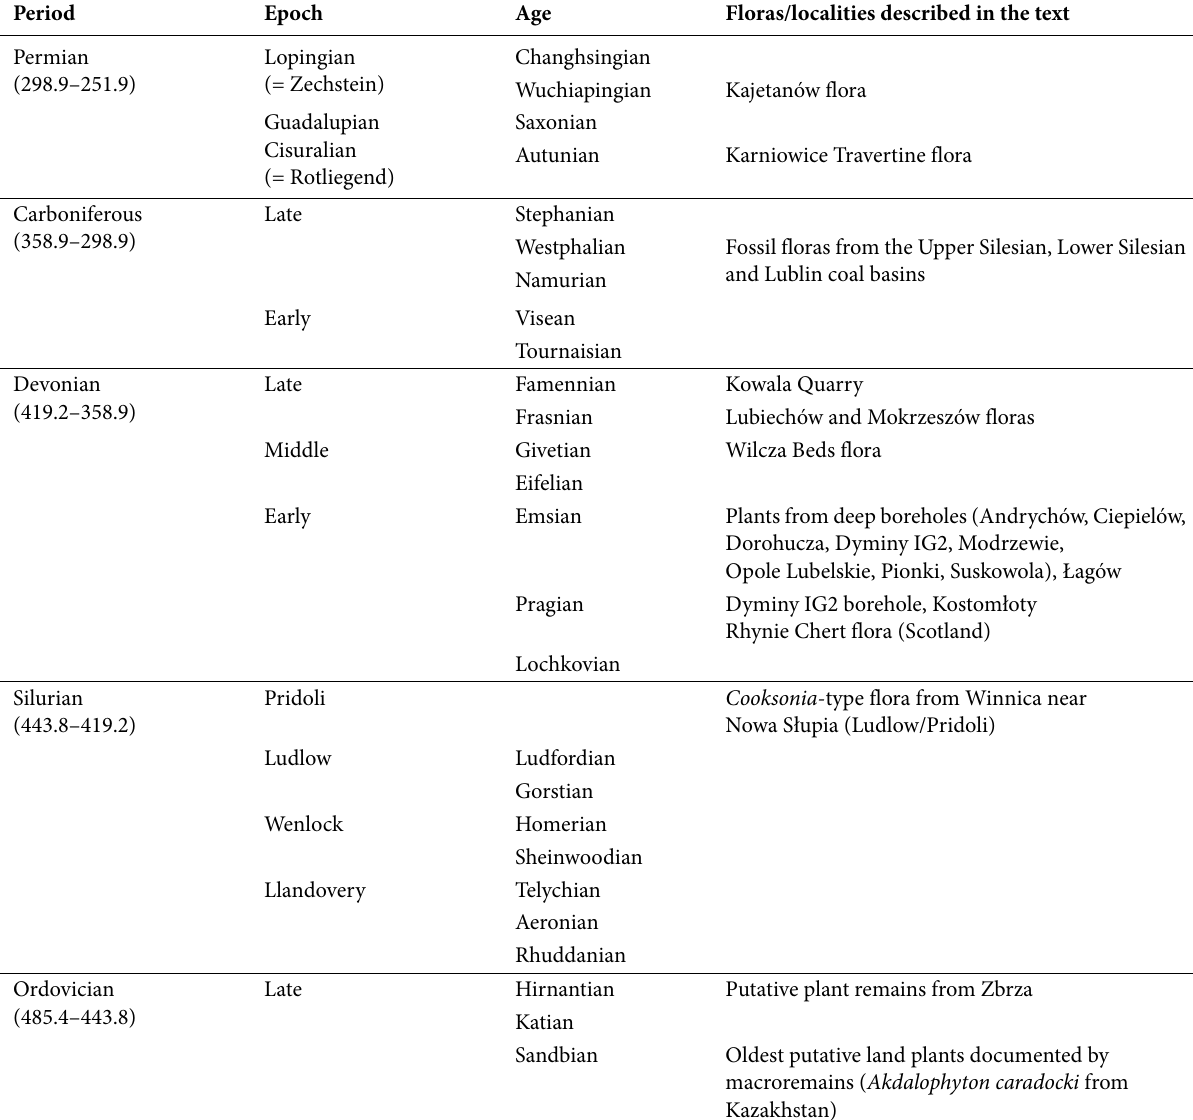
Table 1 Stratigraphic position of the floras and localities discussed in the text. Period Floras/localities described in the